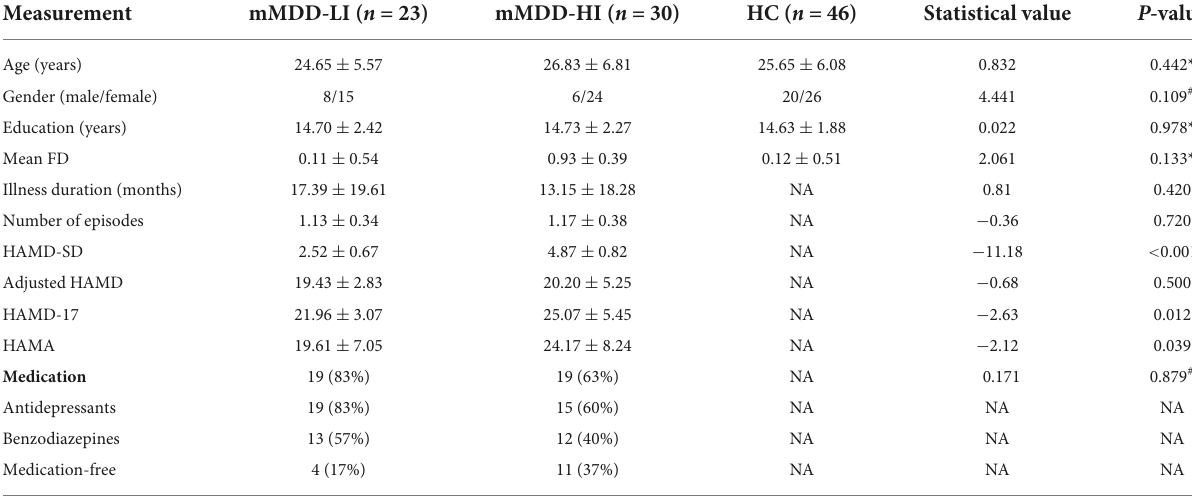
TABLE 1 Demographic and clinical measurement among three